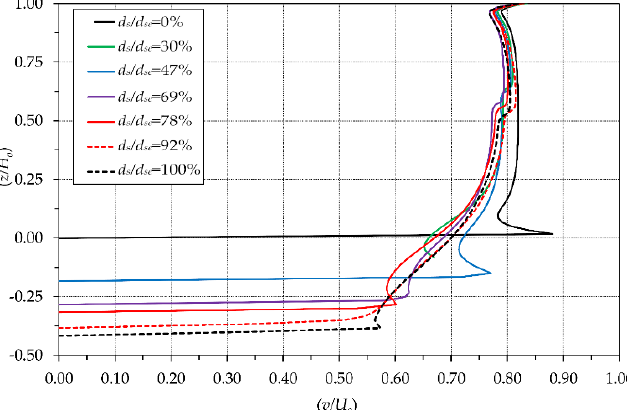
Figure 11. Lateral velocity profiles at the location of maximum positive lateral velocity.